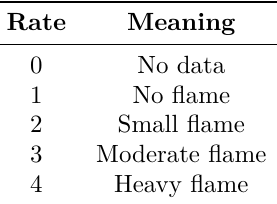
Table 1. The qualification of flaming rates